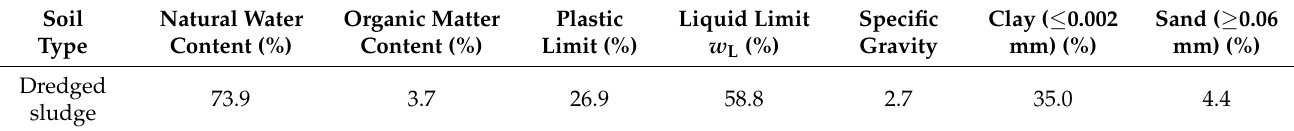
Table 1. Physical properties of dredged sludge.